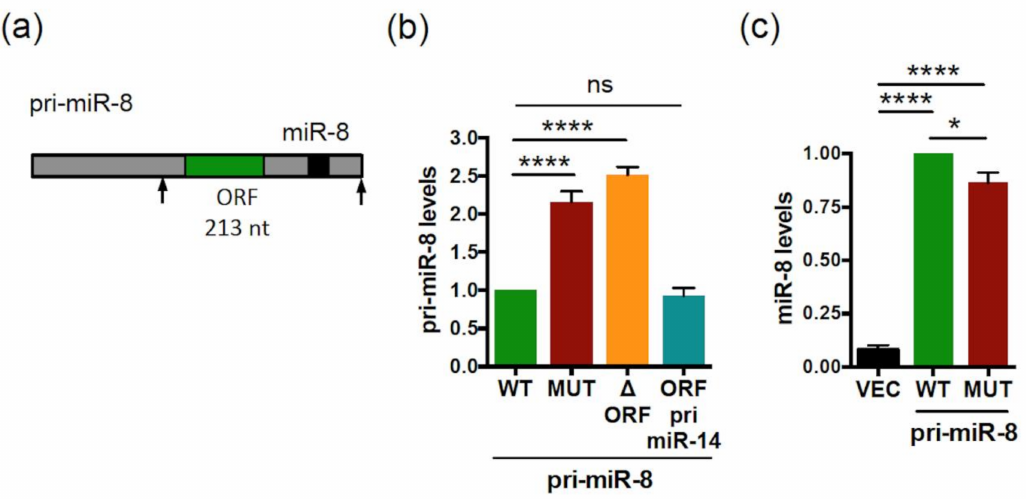
Figure 4. The Drosophila pri-miR-8 contains a smORF regulating its expression level. ( a ) Schematic structure of Drosophila pri-miR-8 with the miR-8 (black box) and smORF213 (green box) indicated. The arrows in the pri-miR-8 delimit the sequences used for analyses. ( b ) Relative expression levels of pri-miR-8 WT or ATG-mutated (MUT) or deleted of the entire smORF213 (ORF) or with the smORF213 replaced by the smORF225 from pri-miR-14 (ORF pri-miR-14) transfected in S2 cells and determined by qRT-PCR. The pri-miR-8 levels were normalized to GAL4 (using pActin-GAL4 vector cotransfected with the pri-miRNA expression plasmids and used to monitor transfection efficiency) and set to 1 for the WT pri-miR-8 transfected cells. Data are means ± S.E.M. n = 10. ( c ) Relative expression levels of miR-8 from vector (VEC) or WT or MUT pri-miR-8 transfected S2 cells and determined by qRT-PCR. The miR-8 levels were normalized to U14 and compared to the WT pri-miR-8, set to 1. Data are means ± S.E.M. n = 15. * p < 0.05, **** p < 0.0001, ns: not